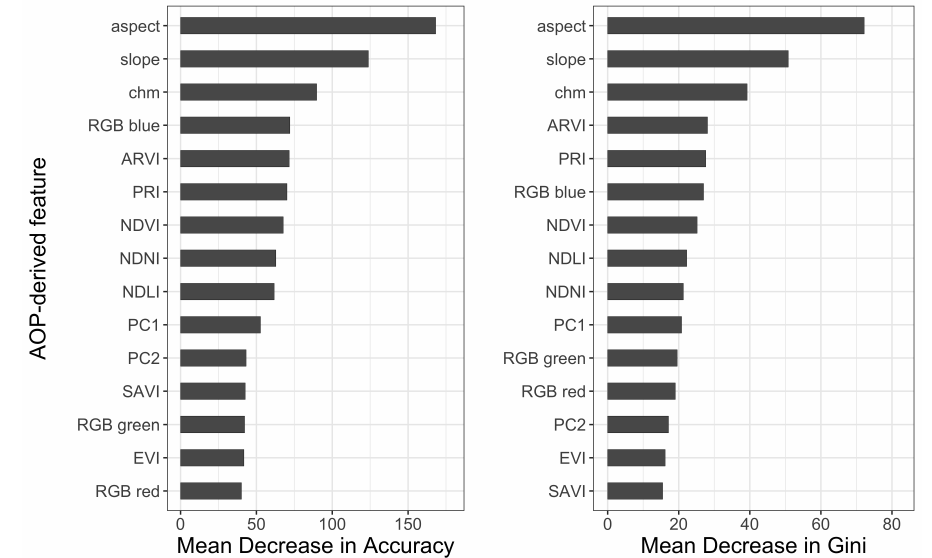
Figure 8. Predictor variable importance ranked by two metrics, Mean Decrease in Accuracy (MDA) and Mean Decrease in Gini Index (MDG) for the Random Forest models trained using the half-diameter clipped polygons. See Table 2 for remote sensing-derived variable